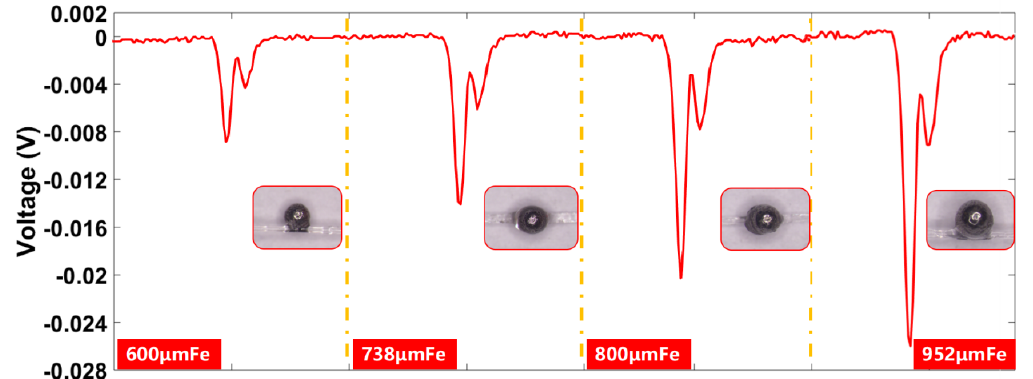
Figure 8. Inductive electric potential generated by iron particles of different particle sizes.